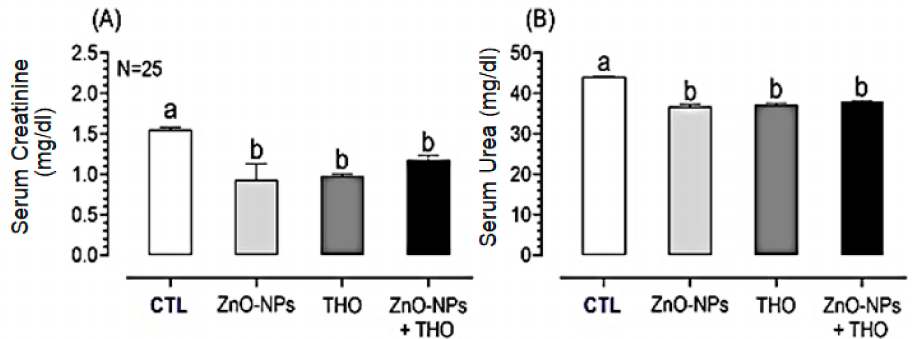
Figure 4. Serum concentrations of creatinine (Cr) ( A ) and urea ( B ) in response to supplementation of ZnO-NPs, THO, ZnO-NPs + THO, or a control (CTL) in male Californian rabbits, respectively. Other explanations were given in Figure 3.